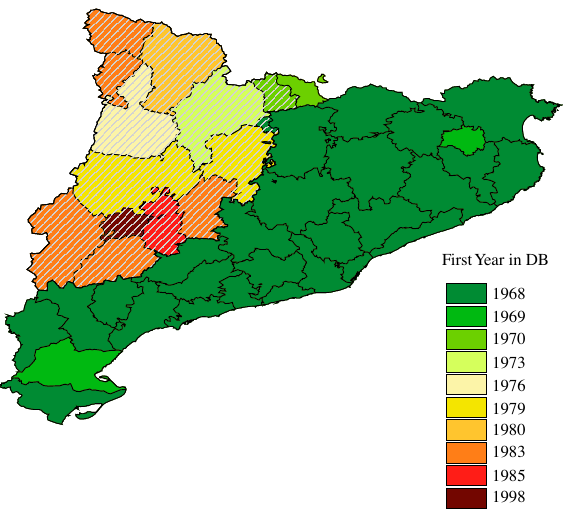
Fig. 1. Map of Catalonia and start year of the fire database for each local administrative division. The two domains of our study are (i) the whole of Catalonia (without the red and brown divisions) in the period 1983–2010, (ii) the eastern part of Catalonia (in green; i.e. excluding the Lleida province), which has a homogeneous fire database for the period 1970–2010.